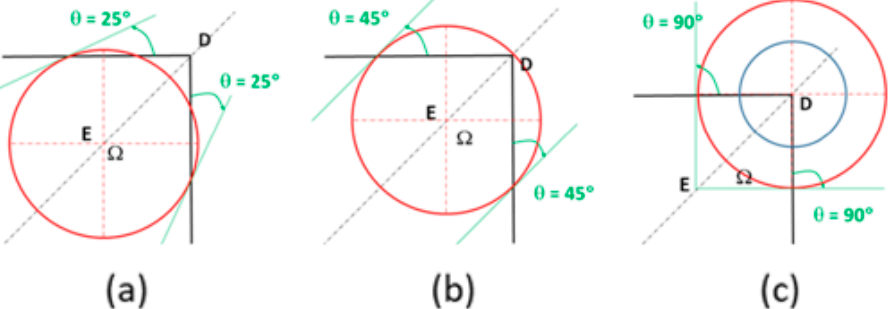
Figure 3. Scheme of the critical wettability angles, with a nucleus on the vertex of a cubic particle. ( a ) Case for θ < 45 o . ( b ) Case for θ = 45 o . ( c ) Case for θ > 45 o .